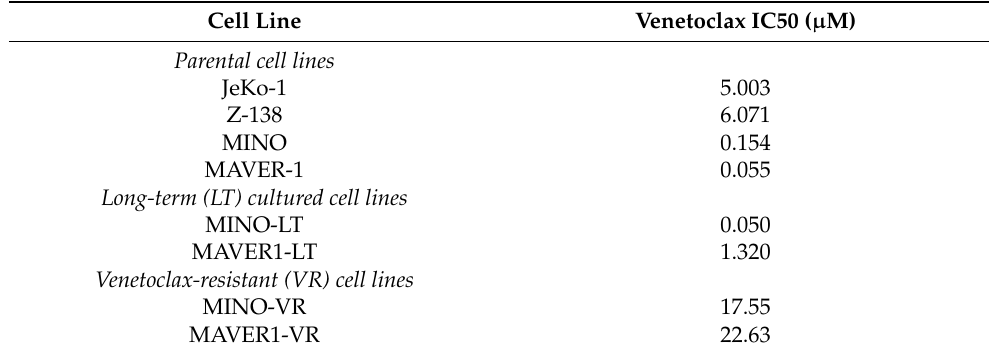
Figure 1. ( a ) Dose-response curves for venetoclax and MINO, (left), MAVER-1 (right). ( b ) Bar charts showing the apoptotic response to venetoclax in co-cultures of MINO (left) and MAVER-1 (right) with HS-5 and MS-5. Data are presented as mean + SD ( n = 3). ( c ) Bar charts with the mean apoptotic response to venetoclax in MCL cells without co-culture (SEP), the co-cultured MCL cells in suspension (SUSP) and the adherent MCL cells in co-culture ADH), shown for MINO (upper) and MAVER-1 (lower) in MS-5 co-cultures. Data are presented as mean + SD ( n = 3). Abbreviations: MINO-LT: long-term cultured MINO; MINO-VR: venetoclax-resistant MINO; MAVER1-LT: long-term cultured MAVER-1; MAVER1-VR: venetoclax-resistant MAVER-1; SD: standard deviation. * p < 0.05, ** p < 0.01, and **** p < 0.0001. Table 1. IC 50 values for venetoclax across all cell lines, as calculated by dose-response